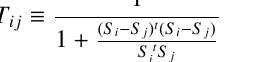
Figure 1. G similarity measure